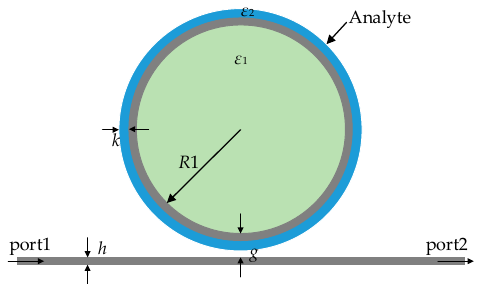
Figure 7. A schematic illustration of the GNW sensor model with a layer of analyte absorbed to the surface of graphene.